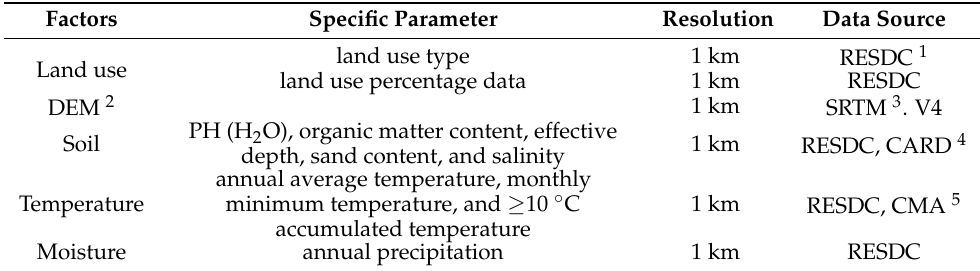
Table 3. Geographic data for planting land